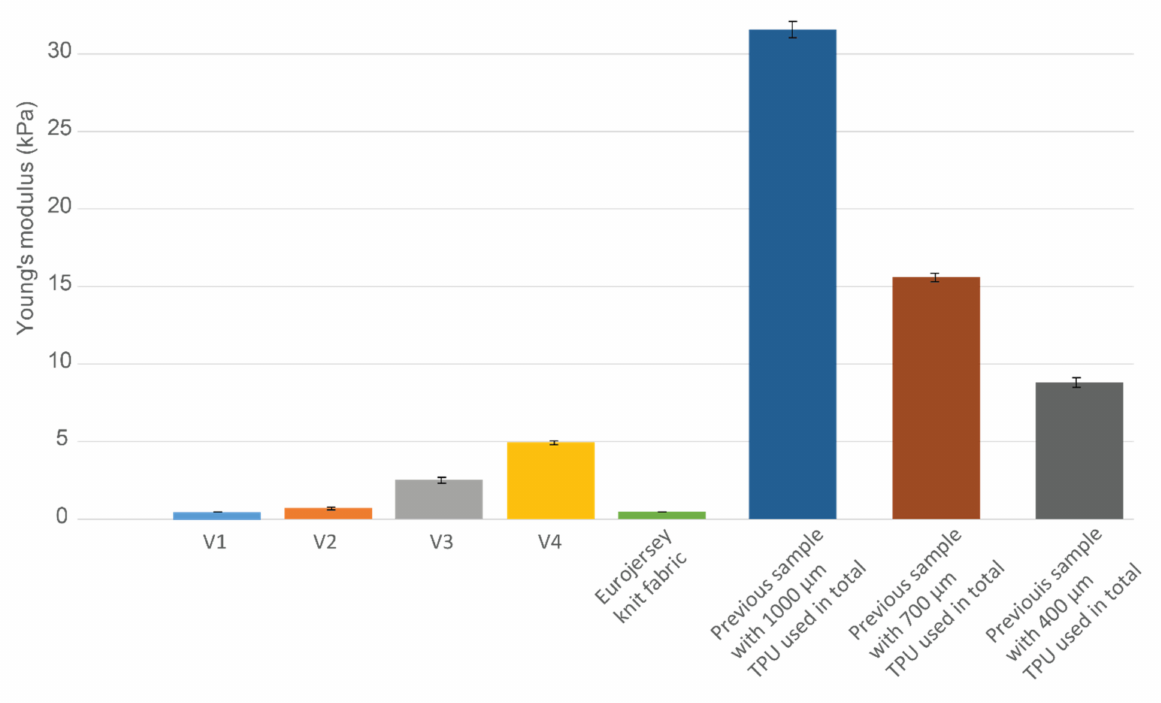
Figure 12. Young’s modulus comparison of current samples, plain knit fabric and previous work